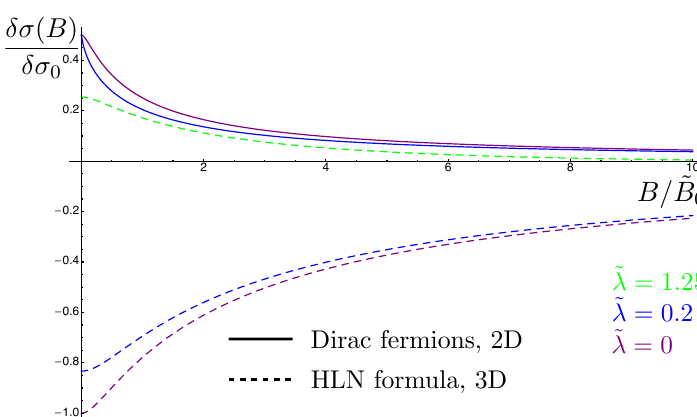
Figure 4. The magnetic field dependence of the quantum correction to the conductivity for massless Dirac fermions (solid lines) and the 3D HLN formula (dashed lines) at different values of the spin-orbit impurities concentrations. Purple plots are for purely scalar disorder ( λ = 0), while blue (green) plots for λ = 0.2 ( λ = 1.25). The magnetic field is given in the unit of ˜ B 0 = e / ( 2 π ¯ hv 2 elastic scattering time in the absence of spin-orbit impurities and v F the Fermi velocity. Adapted from Figure 1 in [154], where δσ ( B ) ≡ ∆ σ ( B ) as defined in Equation